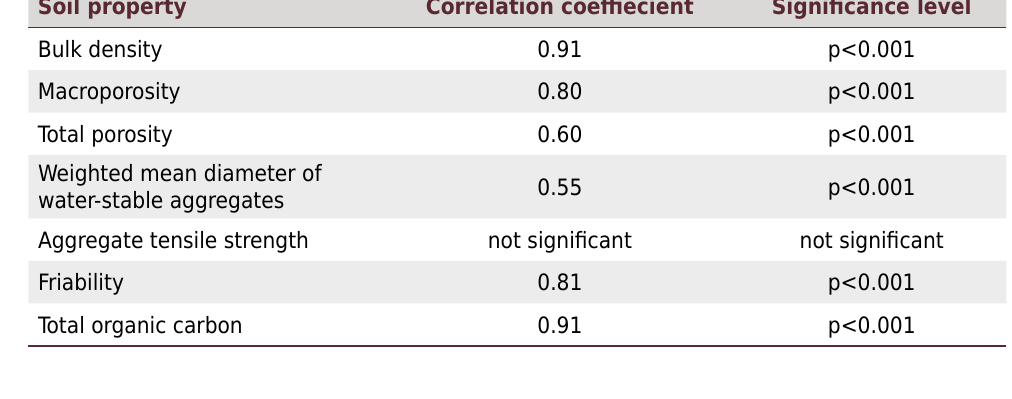
Table 2. Correlation coefficients and their significance levels between VESS scores (Sq) and soil properties Soil property